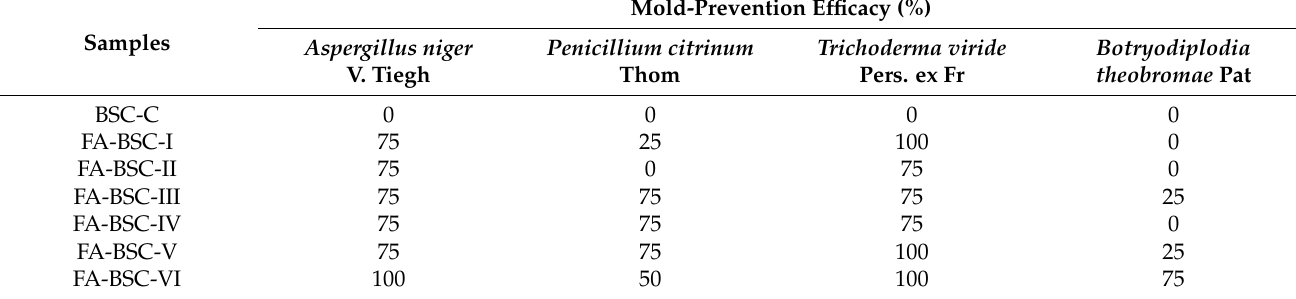
Table 4. Mold-prevention efficacy of